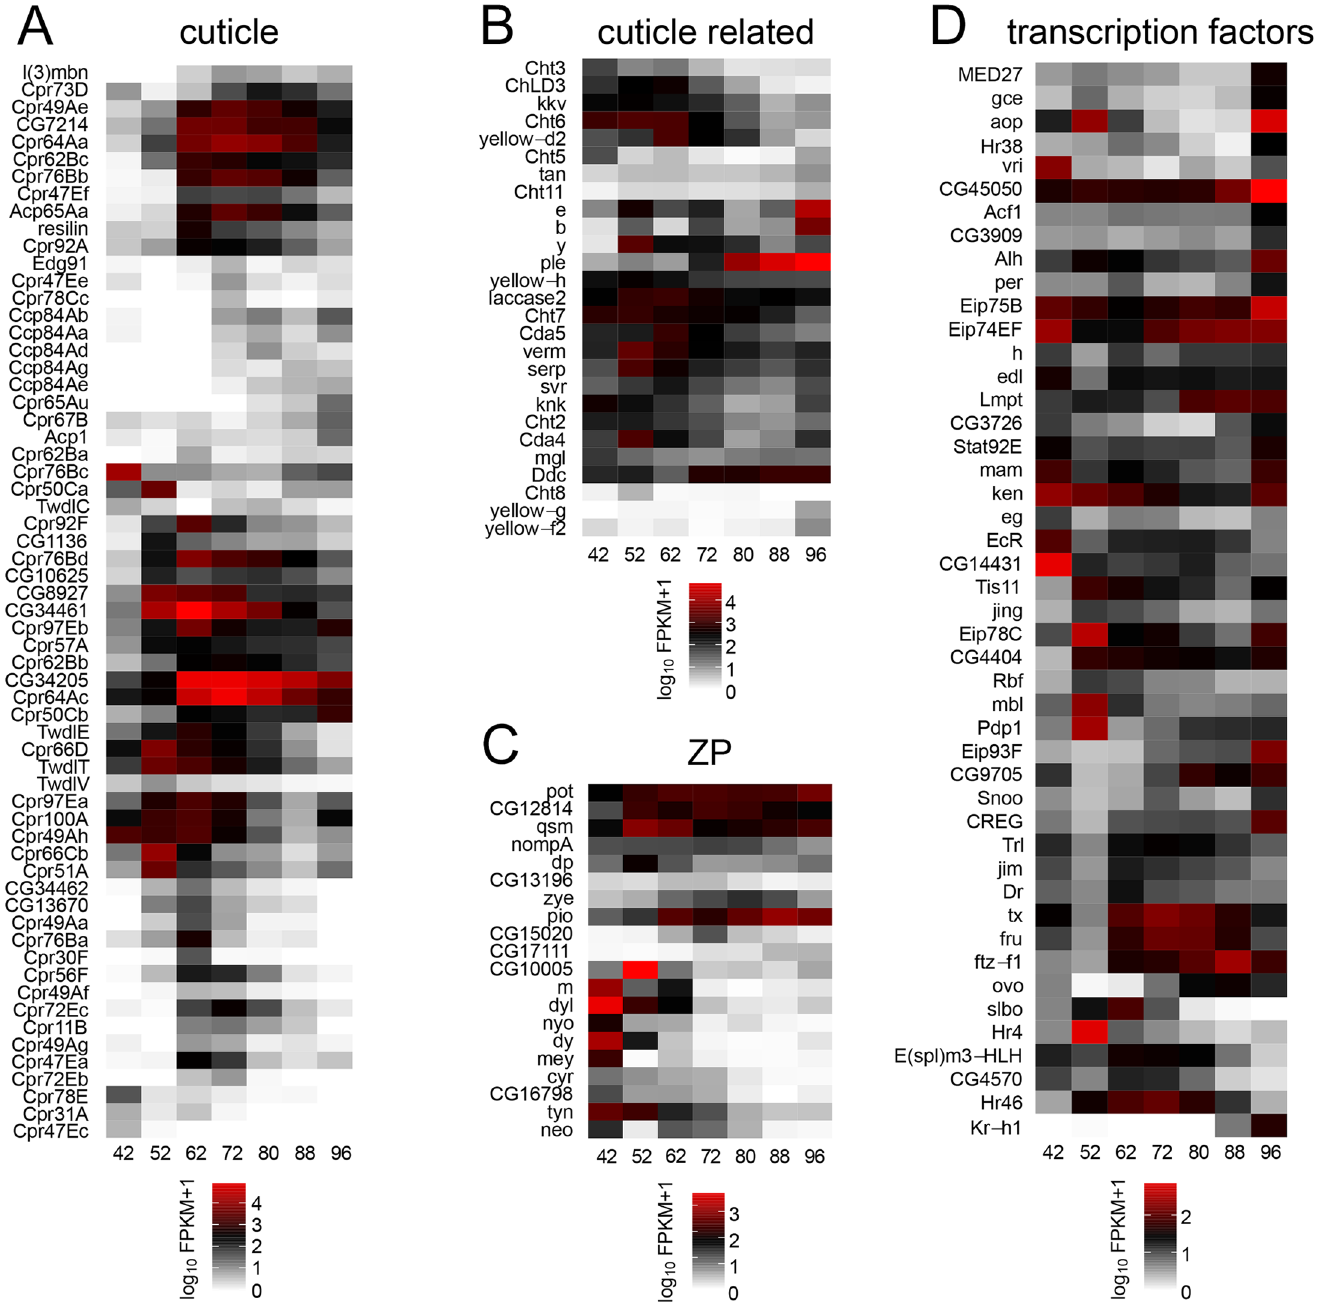
Fig 5. Heat maps for 4 groups of related genes. A. Annotated cuticle proteins. B. Genes with a known function in cuticle deposition or maturation. C. ZP domain protein encoding genes. D. Genes that regulate transcription.